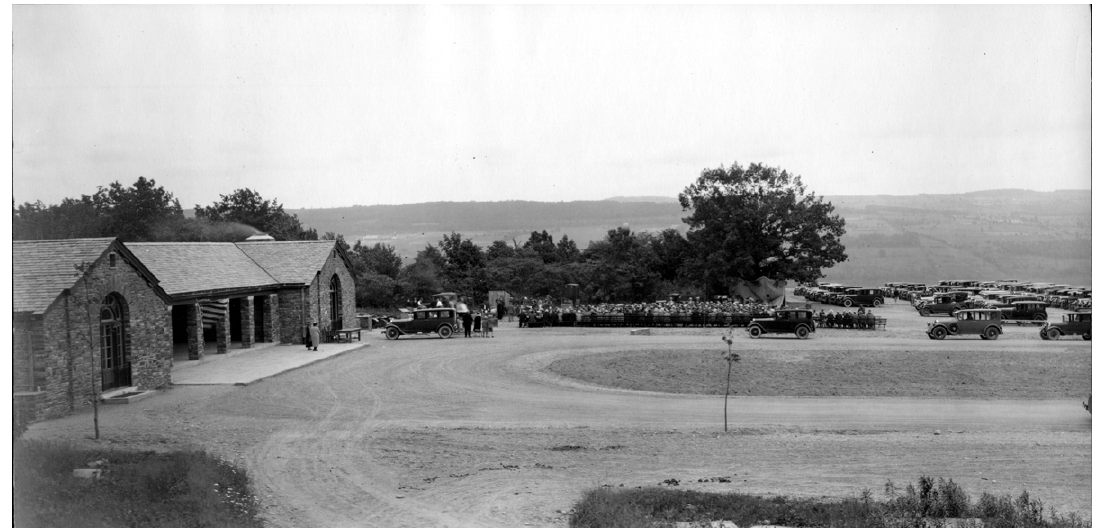
Figure 10. Minnehaha Falls ca. 1890 ( a ) and ca. 1920 ( b ) Photos used with permission: NY State Office of Parks, Recreation & Historic Preservation; parks.ny.gov (accessed on 12 June 2019).